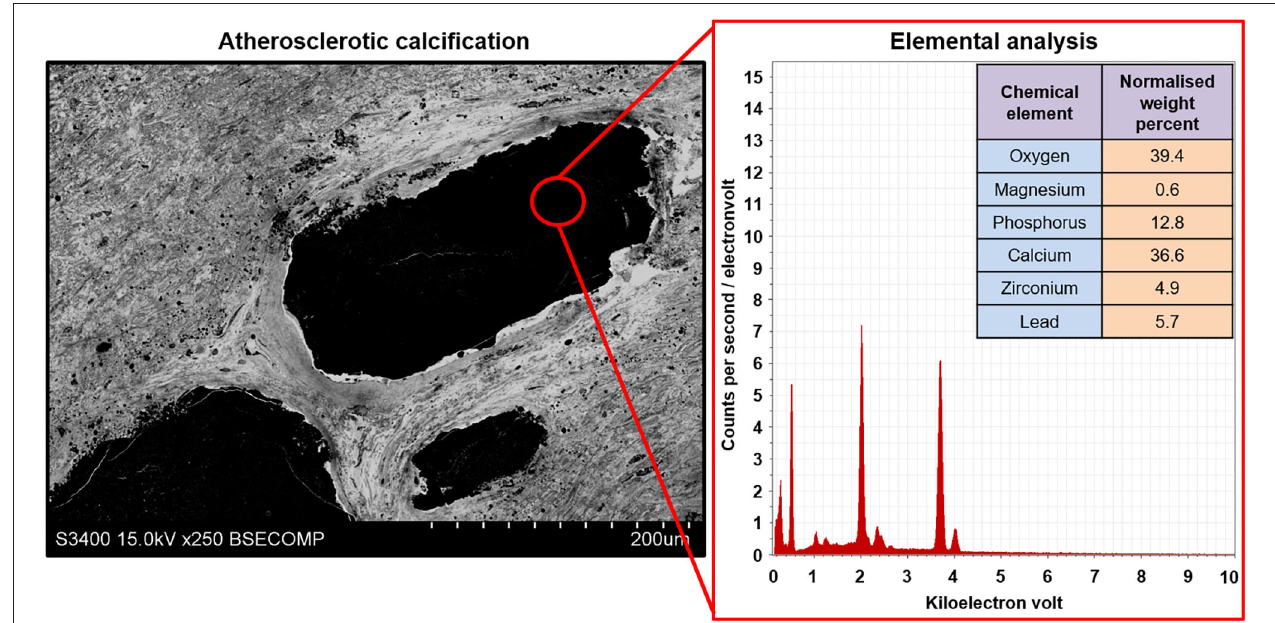
FIGURE 10 | Elemental analysis of the atherosclerotic calcium deposit within the carotid plaque visualised employing EM-BSEM. Note the high calcium, phosphorus, and oxygen content suggestive of a hydroxyapatite. For a more precise elemental analysis, uranyl acetate should be replaced by UranyLess, and lead citrate should be avoided. Yet, this results in a worse detailing of cells and the extracellular matrix. A magnification of × 250 (scale bar: 200 µ m) and accelerating voltage of 15 kV.